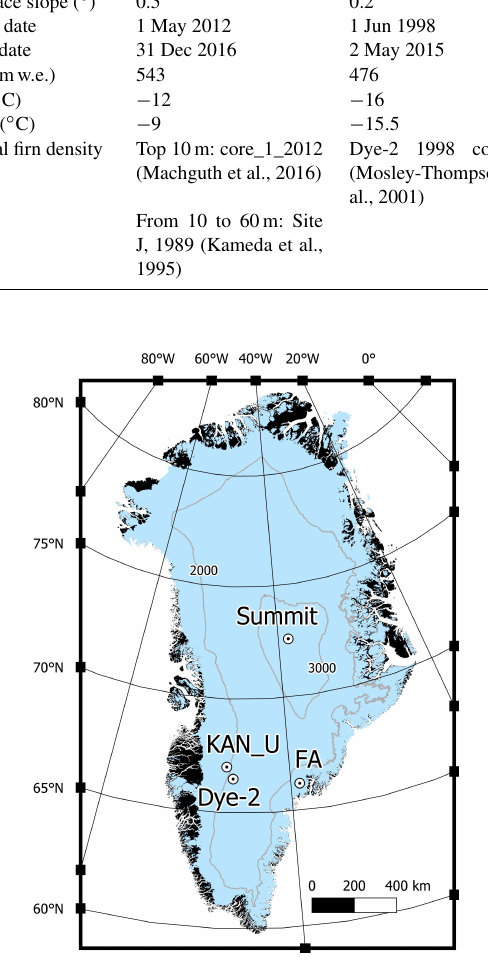
Figure 1. Map of the four study sites. Elevation contours are in meters above sea level.